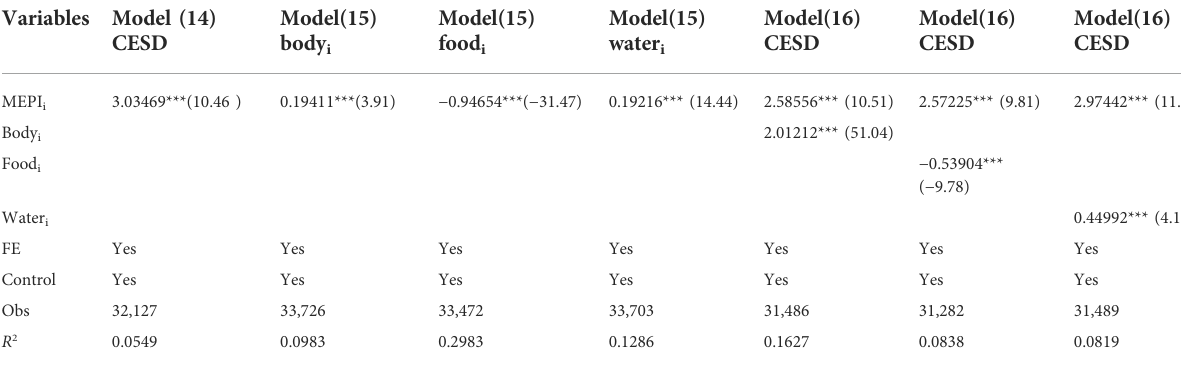
TABLE 7 Mediation effect results regarding mental